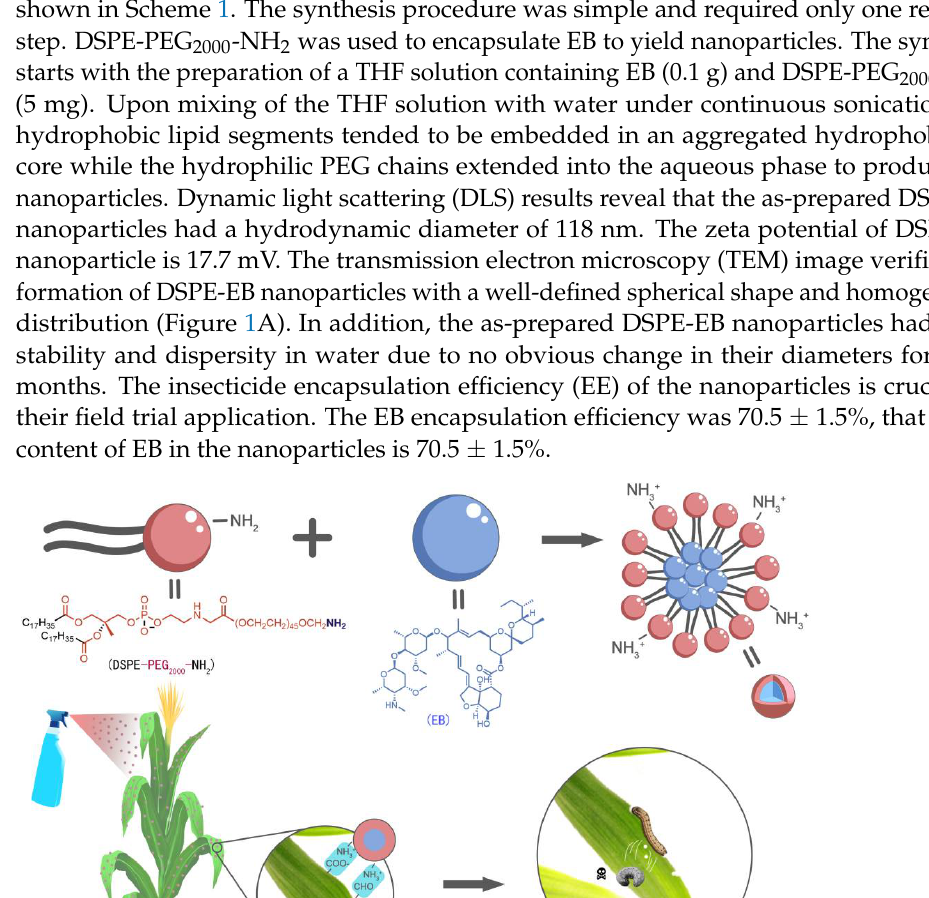
Figure 1. DLS size distribution and TEM images of DSPE-EB nanoparticles ( A ); the absorption spec- tra of DSPE-EB nanoparticles and free EB in ethanol ( B ). 3.2. Retention Property and Wettability of DSPE-EB Nanoparticles 3.2.1. Wetting Performance Analysis An important way to improve the effective utilization of pesticides is to improve their leaf spread performance on target crops. This study evaluated the contact angle of 0.02% aqueous solution of the DSPE-EB nanoparticles and EB-EC on the maize foliage. As shown in Figure 2A,B, the contact angles of the DSPE-EB nanoparticles and EB-EC were 47.26° ± 0.96° and 62.41° ± 1.37°, respectively. The smaller the contact angle of a droplet, the easier its distribution and spreading on the foliage surface of the targeted crops.